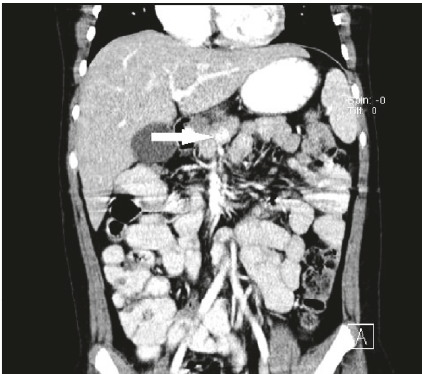
Figure 2: Abdominal CT scan (coronal view) shows intrapancreatic tumor (arrow).